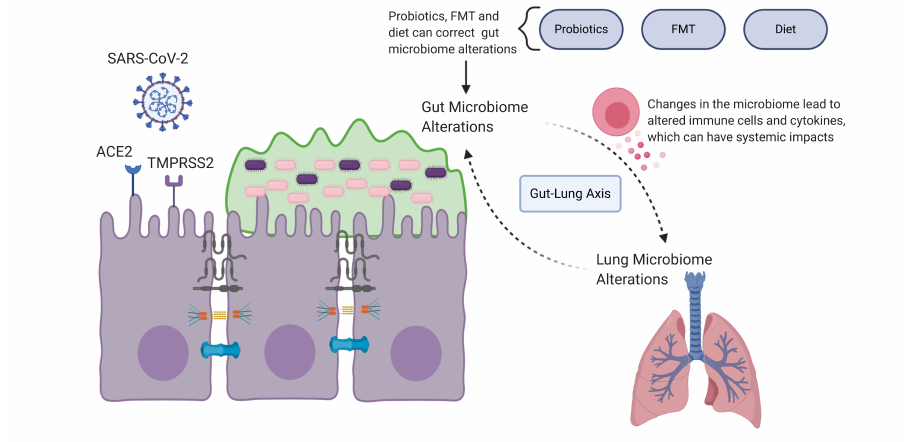
Figure3. ThisfiguredelineatesthelinkbetweenSARS-CoV-2-relatedintestinalpathologyandpathology associated with disruption of the gut–lung axis. Supportive treatment strategies to correct gut barrier alterations could potentially have a beneficial e ff ect on rebalancing the gut–lung axis in COVID-19 patients. Figure created with